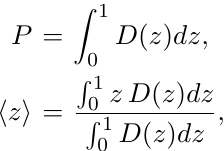
Table 3 . Comparison of the fragmentation probabilities (for g → B c and g → B ∗ this work and those given in ref. [23]. For consistency with ref. [23], the input parameters for our calculation in this table are taken as the same as those in ref. [23], and the integral interval is taken as z ∈ [0 . 01 , 1]